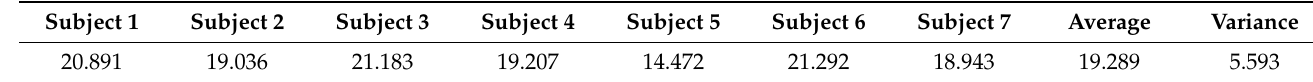
Table 2. Subjects’ interpersonal control according to